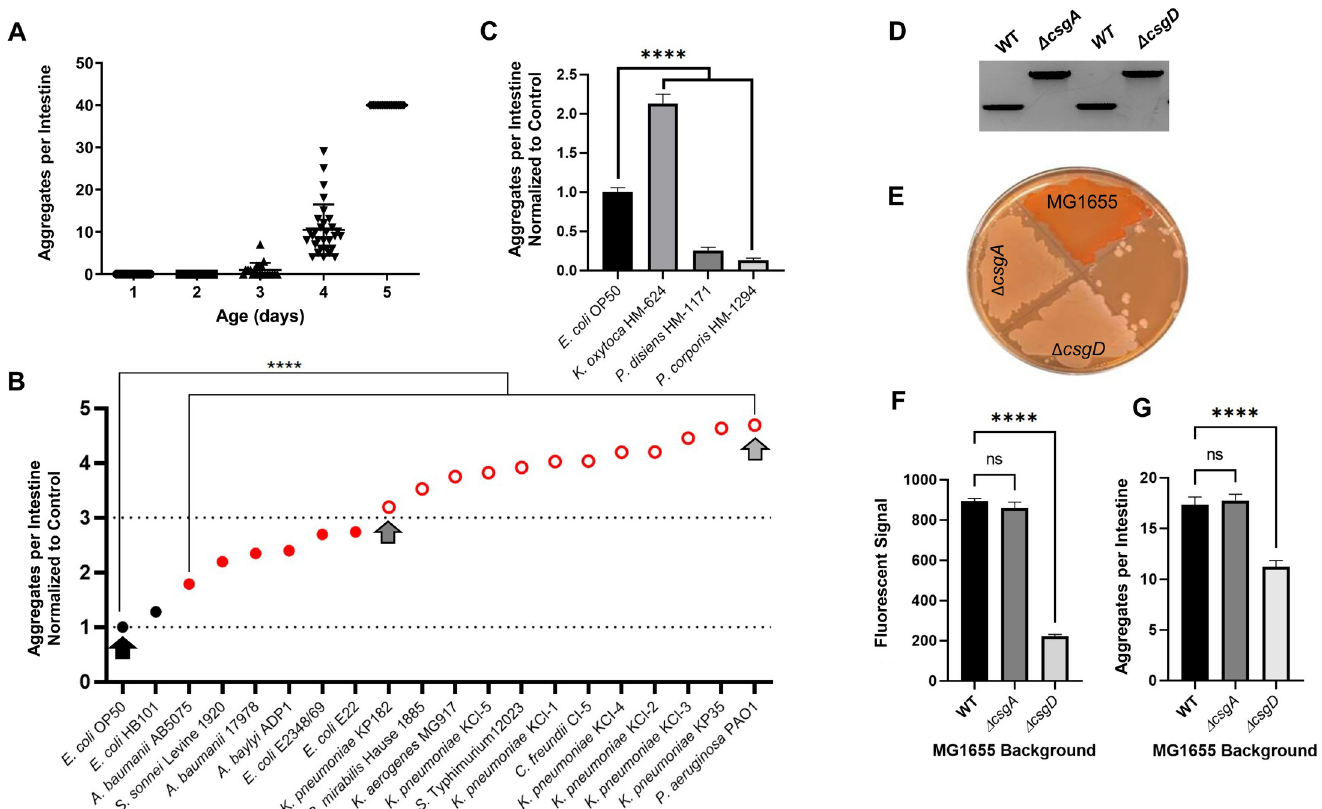
Fig 1. Gram-negative bacteria found in the human gut affect C . elegans proteostasis and enhance protein aggregation in the intestine. A) Age-dependent aggregation of intestinal polyQs (polyQ44) colonized by E . coli OP50. Data are represented as the number of aggregates per 20–30 intestines quantified in animals at day 1–5 post-hatching. B) The effect of select enteric bacteria on polyQ aggregation in the C . elegans intestine. Data are represented as the average number of aggregates per C . elegans intestine normalized to E . coli OP50 control strain (lower dotted line). Each data point is an average of a minimum of three independent experiments with a total of at least 100 animals. Black circles represent control bacteria and bacteria that did not have any significant effect on polyglutamine aggregation upon colonization of the C . elegans intestine. Red solid circles represent bacteria that significantly enhanced aggregation by < 3-fold. Red open circles represent bacteria that significantly enhanced aggregation by > 3-fold (arbitrary threshold). Arrows represent bacteria that were chosen for follow-up experiments. C) The effect of select commensal bacteria on polyQ aggregation in the C . elegans intestine. Data are represented as the average number of aggregates per C . elegans intestine normalized to E . coli OP50 control strain. Each data point is an average of a minimum of three independent experiments with a total of at least 100 animals. D) PCR confirmation of E . coli MG1655 curli mutant strains. WT, csgA :: kan (left two bands) amplified with primers flanking the Δ csgA locus. WT, csgD :: kan (right two bans) amplified with primers flanking the Δ csgD locus. E) Phenotypic confirmation of the curli-deficient Δ csgA and Δ csgD mutant strains using Congo Red plate assay. F) ProteoStat staining of total aggregates produced by E . coli MG1655 wild-type (WT), MG1655 Δ csgA , and MG1655 Δ csgD . Data are represented as the average fluorescent signal per bacterial strain stained with ProteoStat. Each data point is an average of two independent experiments with three replicates per run. G) The effect of E . coli MG1655 curli mutants on polyQ (polyQ44) aggregation in the C . elegans intestine. Data are represented as the average number of aggregates per C . elegans intestine. Each data point is an average of three independent experiments with a total of 90 animals. Error bars represent standard error of the mean (SEM). Statistical significance was calculated using one-way analysis of variance (ANOVA) followed by multiple comparison Dunnett’s post-hoc test ( ���� p < 0.0001).